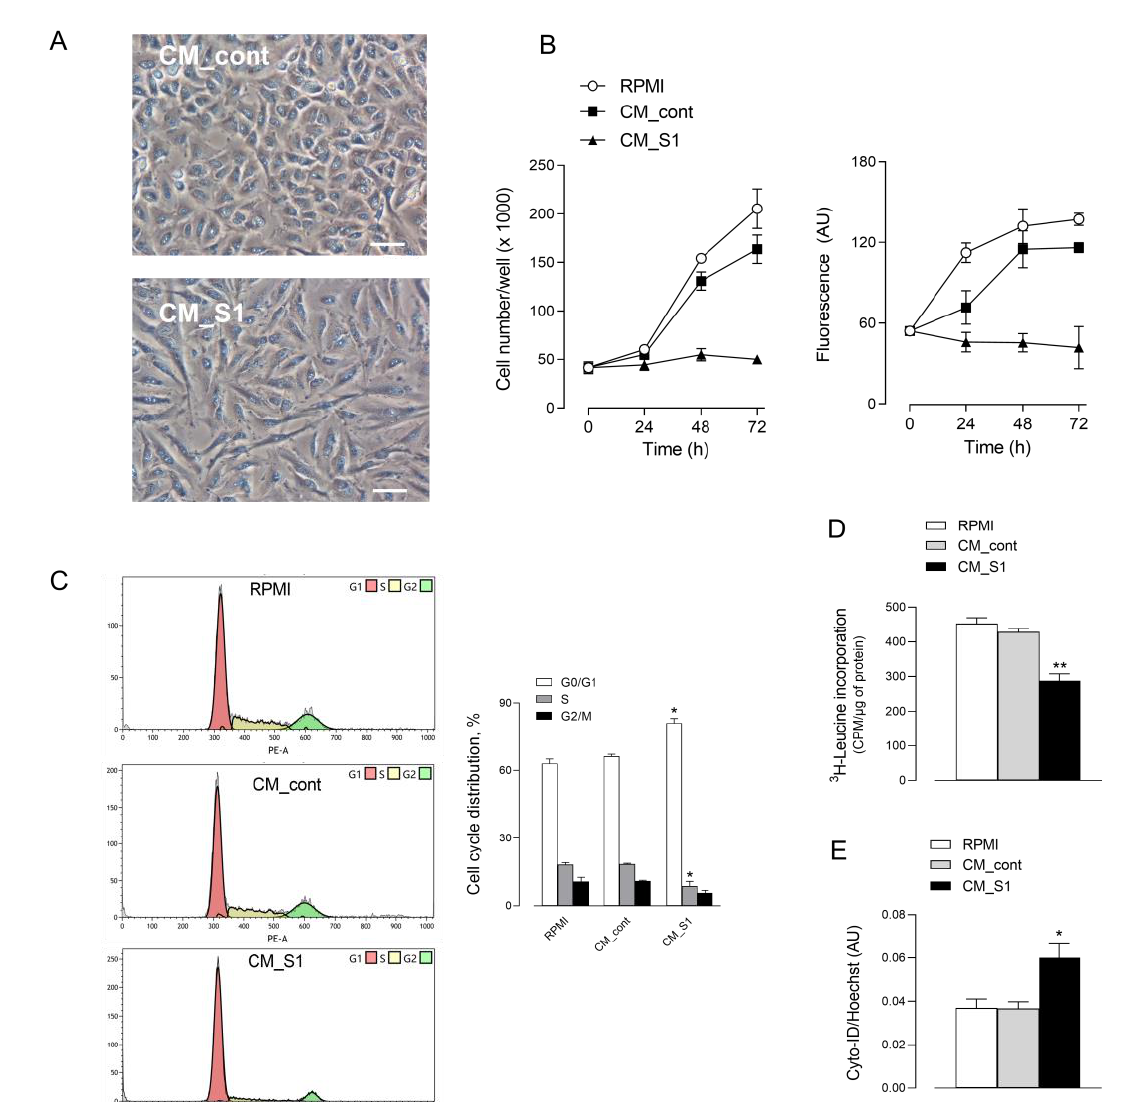
Figure 1. Effects of conditioned medium from S1-treated macrophages on the viability and proliferation of alveolar epithelial cells. A549 cells were maintained in RPMI1640 medium (RPMI) or incubated in conditioned medium obtained by incubating monocytes-derived macrophages in the absence (CM_cont) or in the presence of 5 nM S1 (CM_S1). ( A ) Phase contrast microscopy images of cells treated for 48 h. Bar = 100 µM. ( B ) Cell proliferation. At the indicated times, cell proliferation was assessed by counting the number of adherent cells (left), or by measuring cell viability through resazurin assay (right), as described in Methods. Each point represents the media ± SD of five determinations in a representative experiment that, repeated three times, gave comparable results. ( C ) Cell cycle analysis. After 24 h of incubation, cells were harvested, stained with propidium iodide, and analyzed for cell cycle with flow cytometry as detailed in Methods. Plots obtained in a representative experiment are shown (left). Cell distribution at each phase of cell cycle is also shown (right); bars represent the mean ± SEM of data obtained in three independent experiments. * p < 0.05 vs. CM_cont with ANOVA. ( D ) Protein synthesis. After 24 h, protein synthesis was determined by evaluating the incorporation of 3 H-leucine, as described in Methods. Bars represent the mean ± SEM of three independent experiments. ** p < 0.01 vs. CM_cont with ANOVA. ( E ) Induction of autophagy. Autophagy was determined after 72 h as described in Methods. Bars represent the mean ± SEM of four determinations. * p < 0.05 vs. CM_cont with ANOVA.